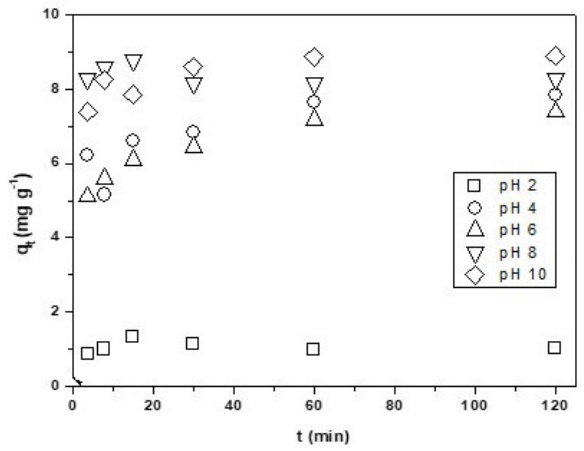
Figure 4. Effect of the pH on the Cu 2+ adsorption onto CNF. Experimental conditions: CNF = 0.1 g, V